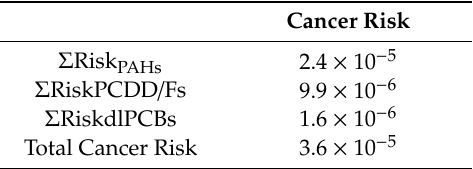
Table 8. Cancer risk for PAHs, PCDD / Fs, and dlPCBs and total risk for citizens of